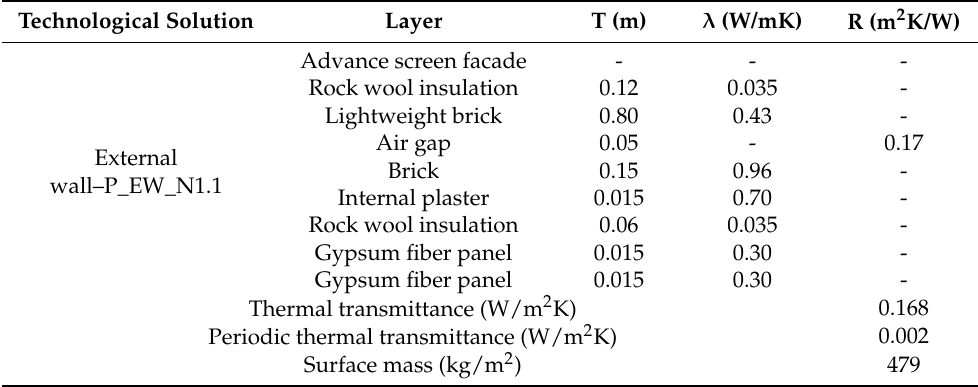
Table A8. Possible upgrade measure of external wall stratigraphy (P_EW_N1.1) with the advance screen façade as external finishing and the thermal transmittance equal to the half of the refer- ence building.